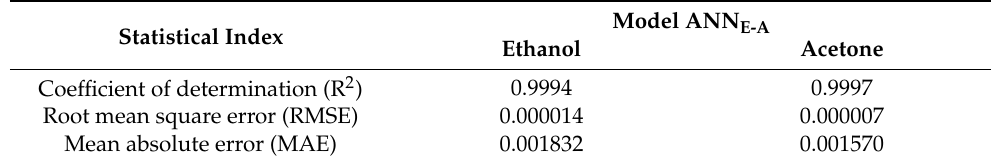
Table 2. Values of indicators used to evaluate the performance of the ANN E-A model to predict the contents of ethanol and acetone in a liquid